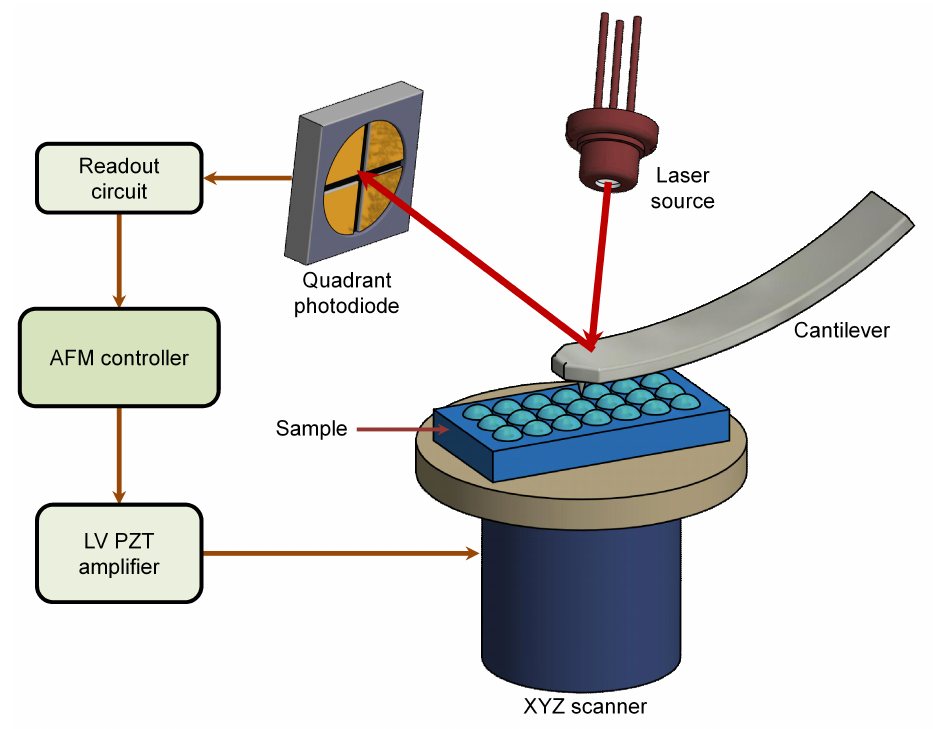
Figure 3. General schematic of a cantilever-based atomic force microscope (AFM) with the laser reflecting onto the